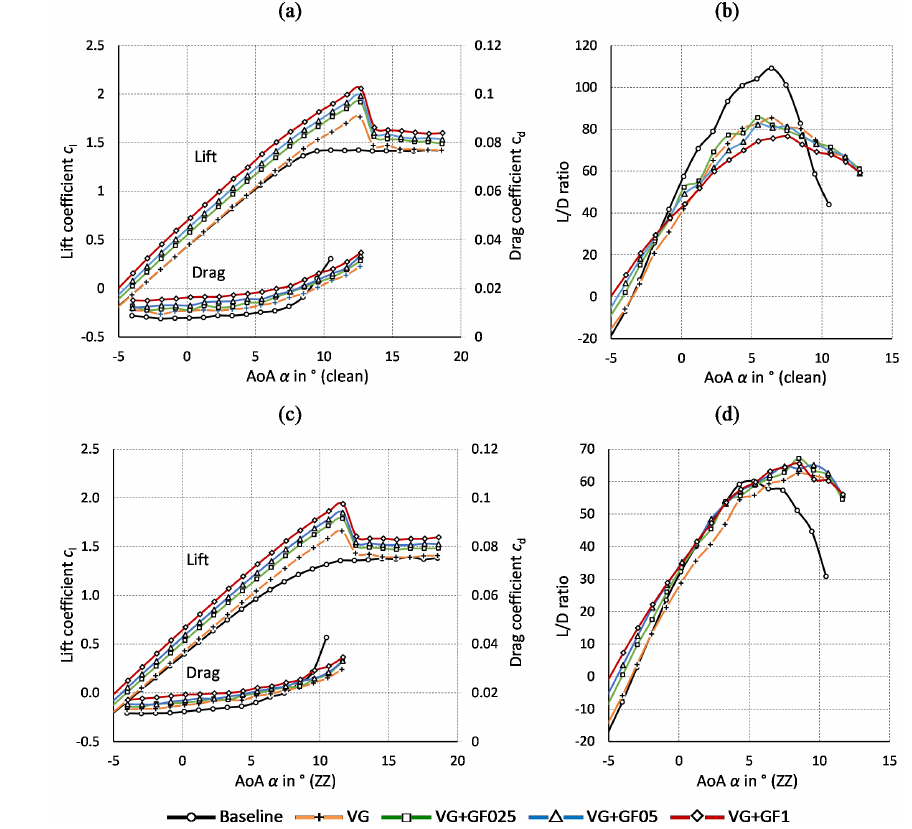
Figure B1. NACA63(3)618. Vortex generators and Gurney flaps. (a) Lift and drag coefficients (clean). (b) L/D ratio (clean). (c) Lift and drag coefficients (ZZ). (d) L/D ratio